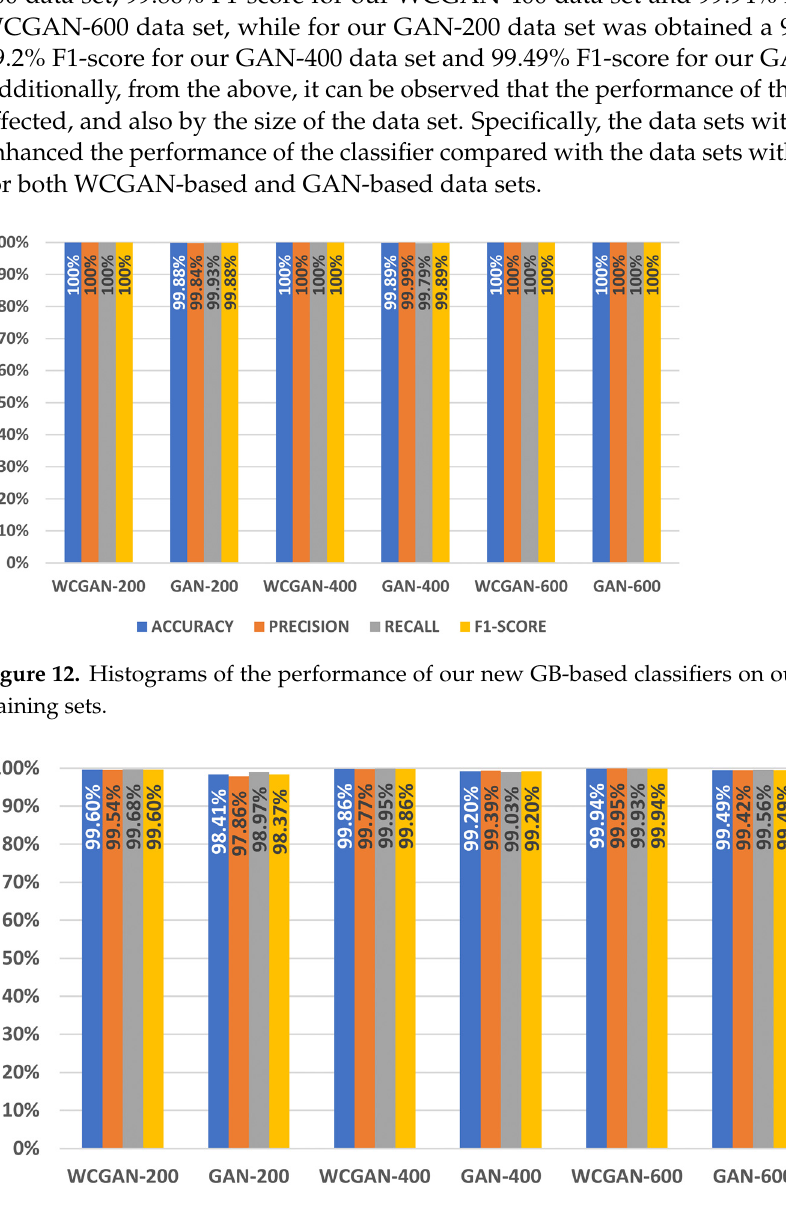
Figure 14. Histograms of the performance of our new GB-based classifiers on our mixed training sets.